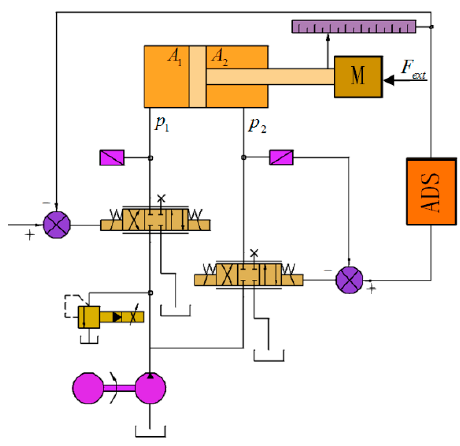
Figure 1. Separating-metering system with active damping strategy (ADS).